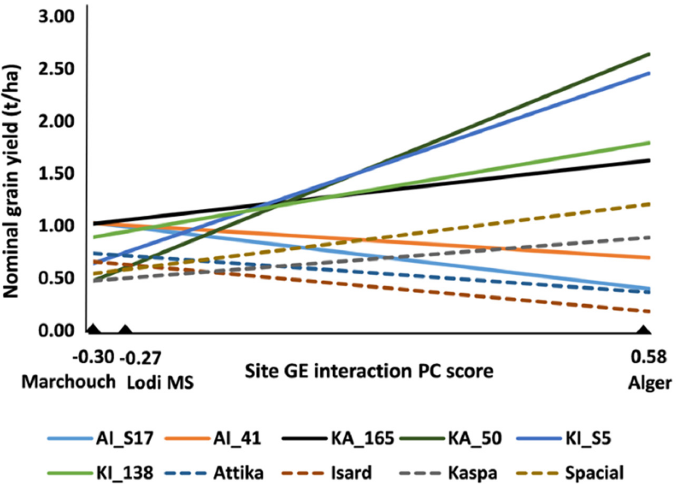
Figure 6. Additive main effects and multiplicative interaction (AMMI) − modeled nominal grain yield of six top-performing pea lines out of 288 lines belonging to three connected RIL populations, including the two top − ranking lines in each site or over sites, three parent cultivars (Attika, Isard, and Kaspa), and one recent control cultivar (Spacial), grown in a managed drought stress (MS) environment of Lodi (Italy) and two rainfed agricultural environments of Marchouch (Morocco) and Alger (Algeria). Source: [47].